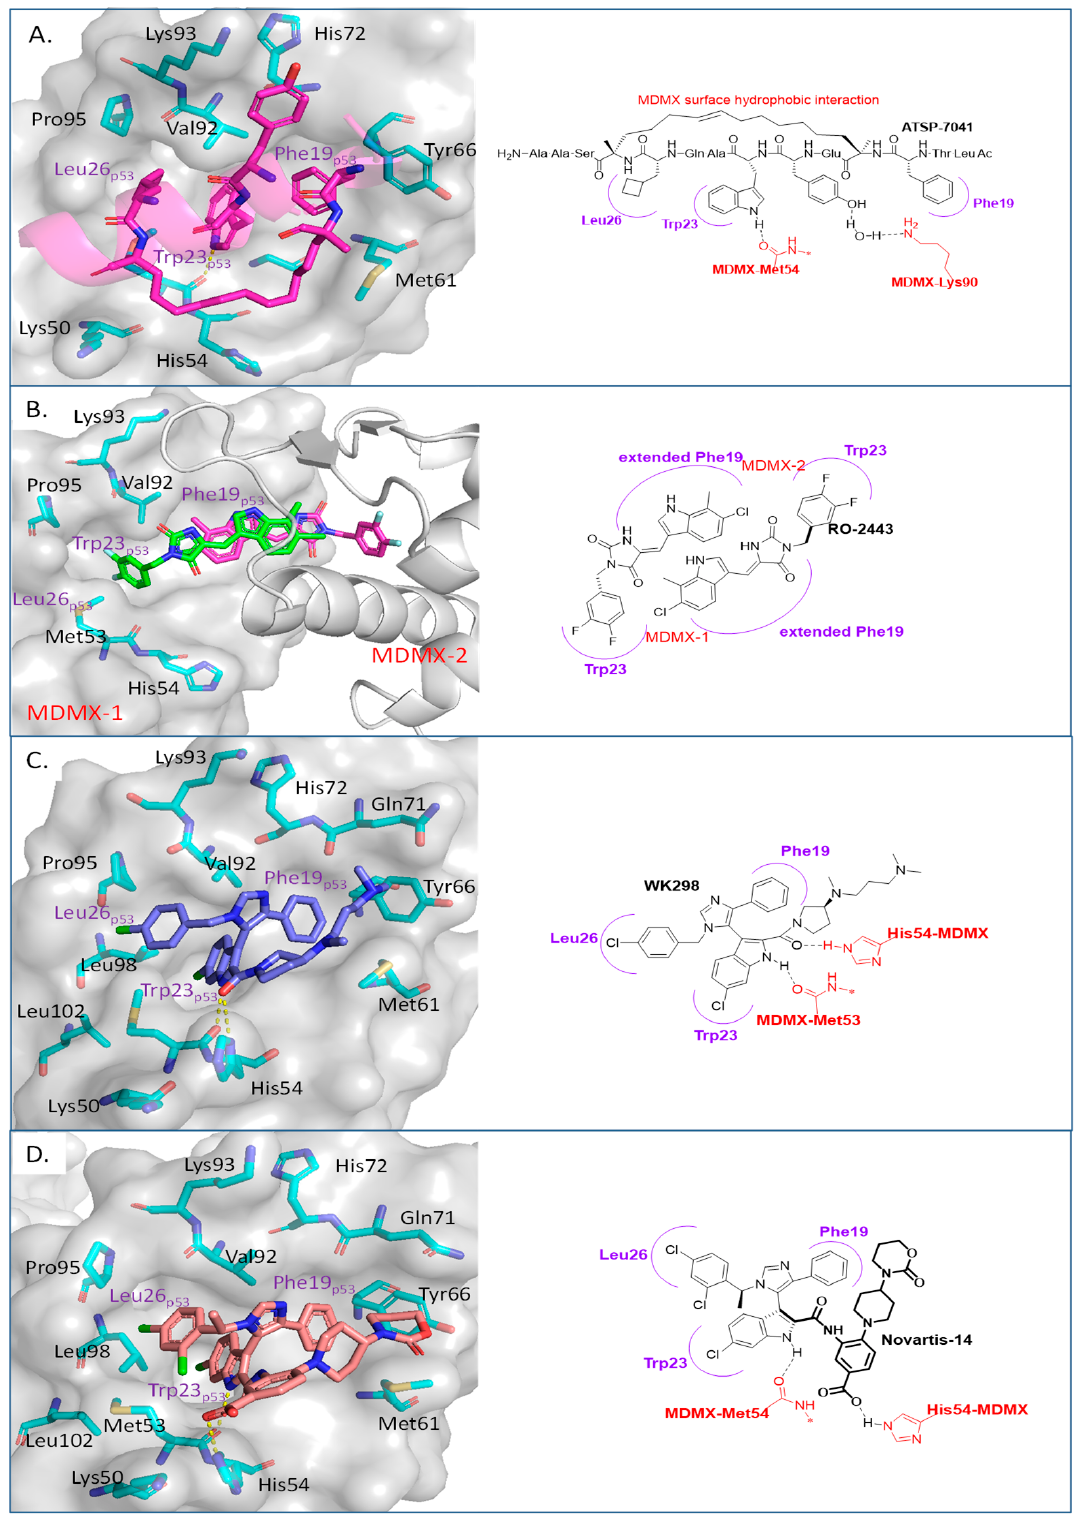
Figure 10. Co-crystal structures and chemical structures of inhibitors bound to MDMX protein: ( A ) ATSP-7041; ( B ) RO-2443; ( C ) WK298; ( D ) and Novartis-14. Labels and semicircles in magenta indicate the binding pockets in MDMX where the p53 residues Phe19, Trp23, and Leu26 bind. Labels in red indicate MDMX